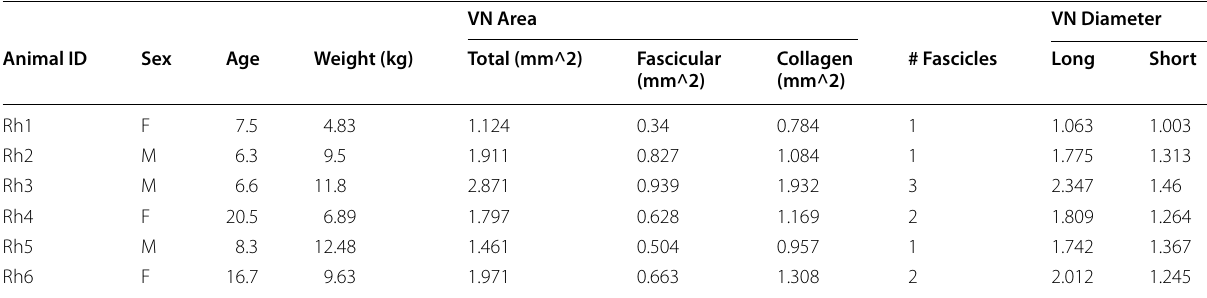
Table 1 Demographic and histological details for the NHP vagus nerves examined. Cross sectional areas of nerve features are represented as the total area as well as that of the fascicular bundles and the supporting collagen structures. Most nerves were not circular, thus the diameter is measured along the short and long axes VN Area Animal ID Sex Age Weight